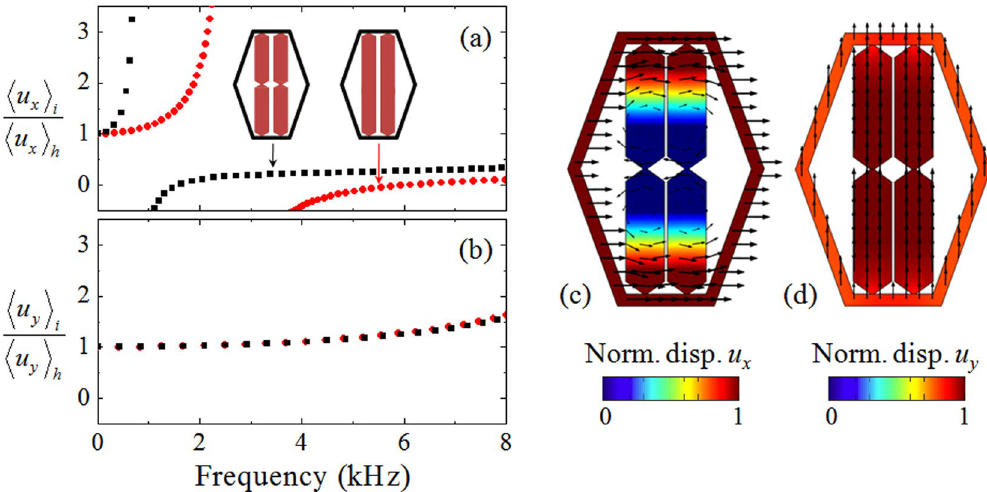
Figure 4. Displacement field distributions of some specific eigenstates. Average displacements of the inclusion with respect to the lattice host, ( a ) u u / , and ( b ) u u / , calculated respectively from LX and LY band x i x h y i y h diagrams. Mode shapes of displacement fields ( c ) u x and ( d ) u y at a certain frequency 3 kHz that is inside the linear dispersion regime. ( c ) The u field verifies that the central region of the inclusion remains almost x motionless, mimicking the sliding-boundary effect in fluid-solid composites. The slender cross-section carved at the middle of the bar helps to further diminish the resonant frequency as verified by a comparison to the straight-bar case. ( d ) Uniform displacement distribution u observed in the LY mode explains why ρ reaches y y the composite average